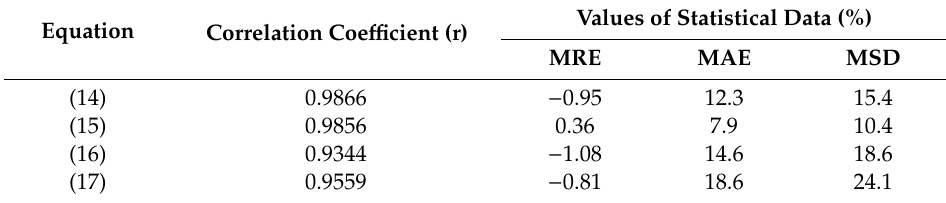
Values of Statistical Data (%)